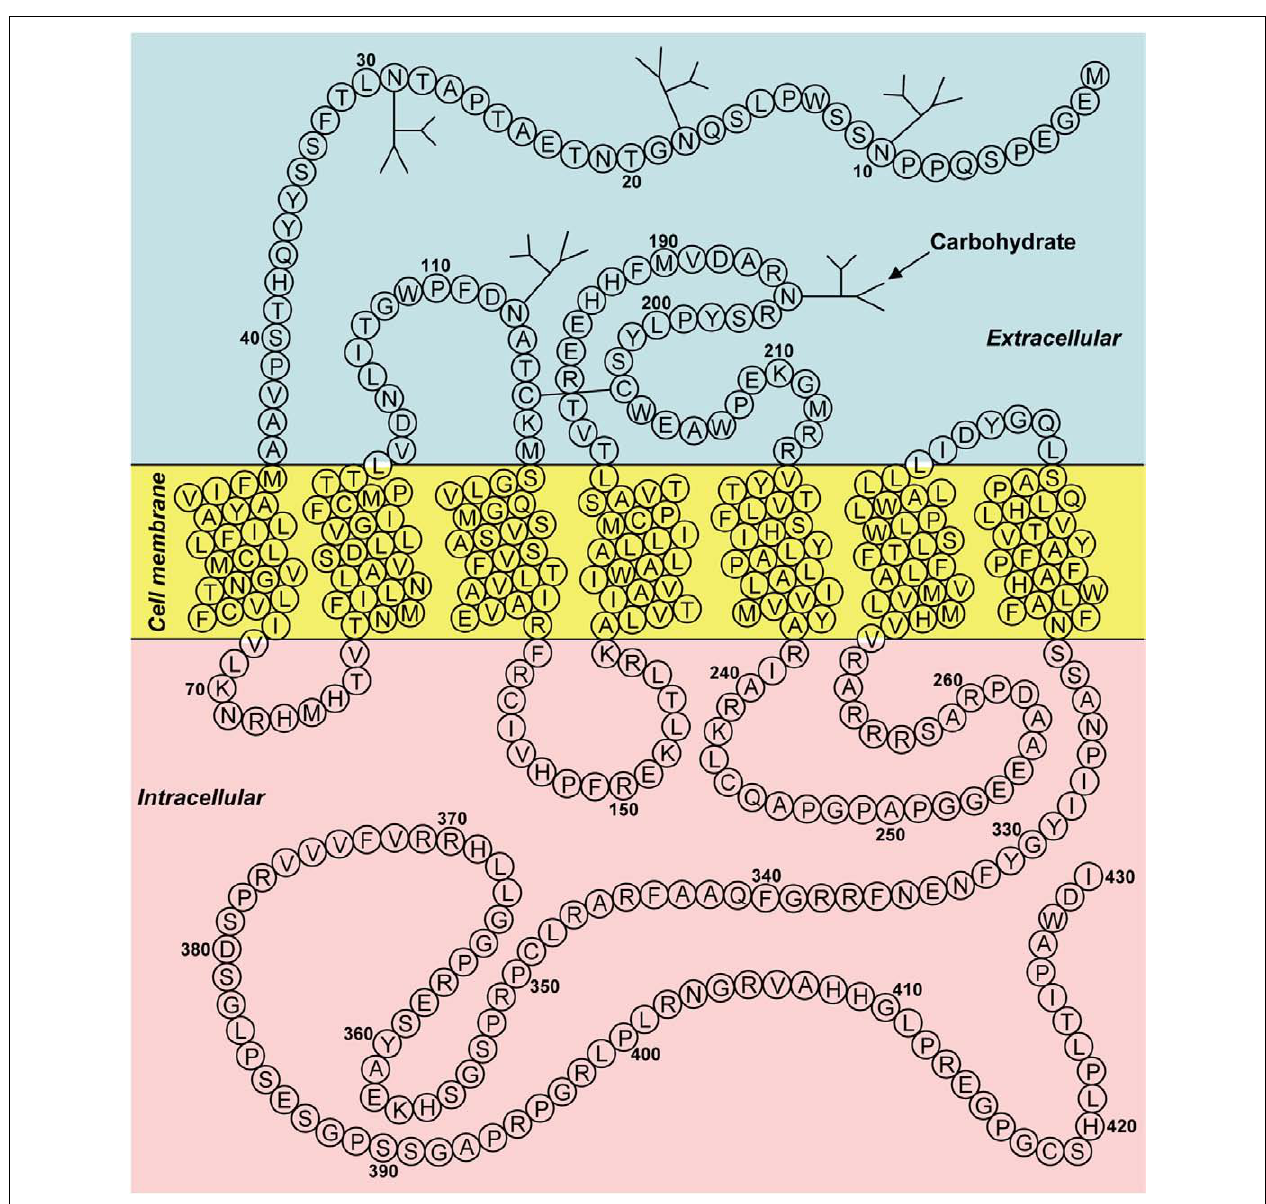
FIGURE 2 |Two-dimensional representation of the receptor (GPR147) for human GnIH (RFRP). The transmembrane region was predicted using SOSUI (Hirokawa etal., 1998). Glycosylation and disulfide bridge sites were predicted by GPCRDB (Horn etal., 1998).The accession number is AB040104. Adapted from Ubuka etal.